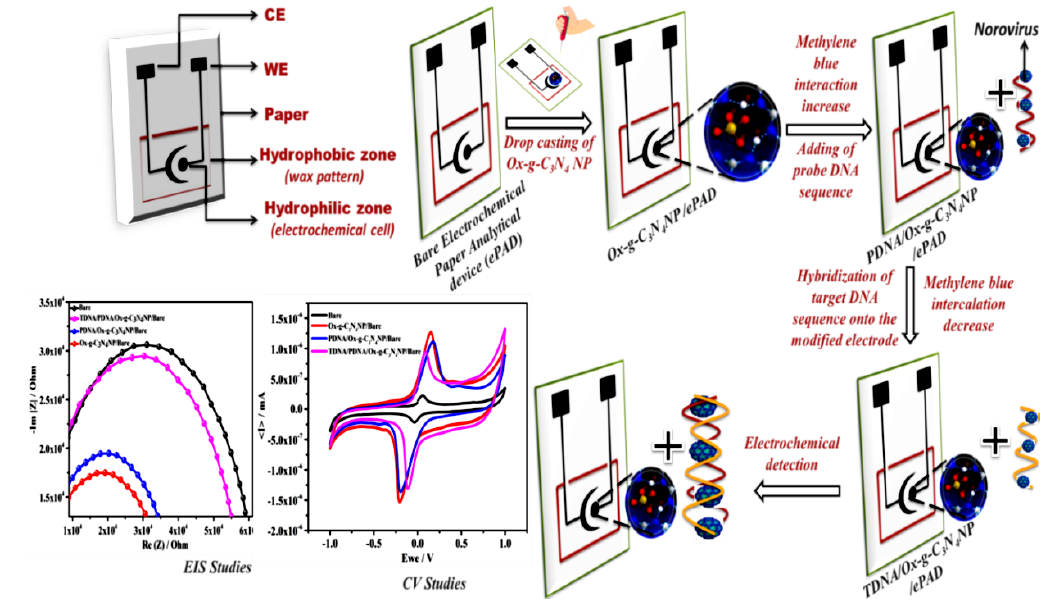
Scheme 1. Schematic representation of the fabricated biosensor.